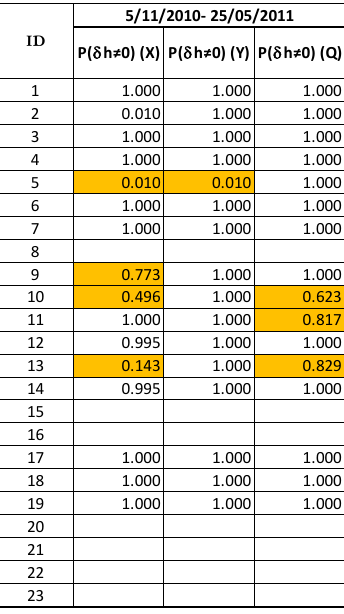
Table 13. Results of Bayesian analysis with prior data